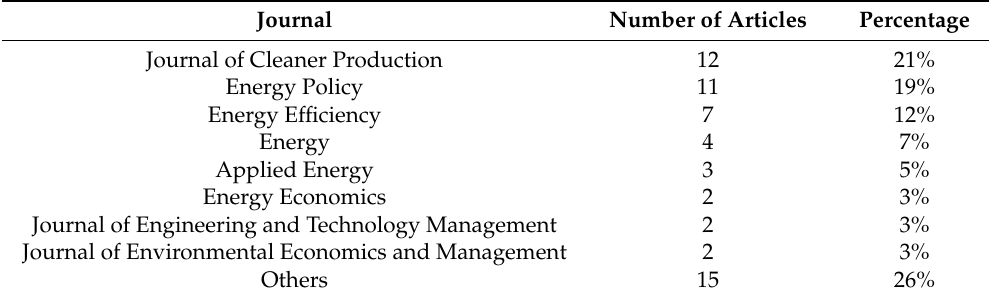
Table 2. Top publishing journals on drivers to energy efficiency.